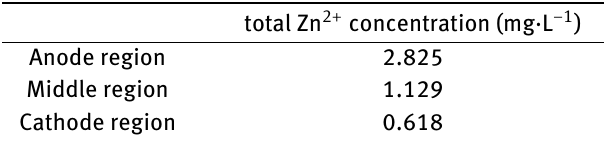
Table S2: Total Zn 2+ concentration of three regions in electric field-hydrothermal